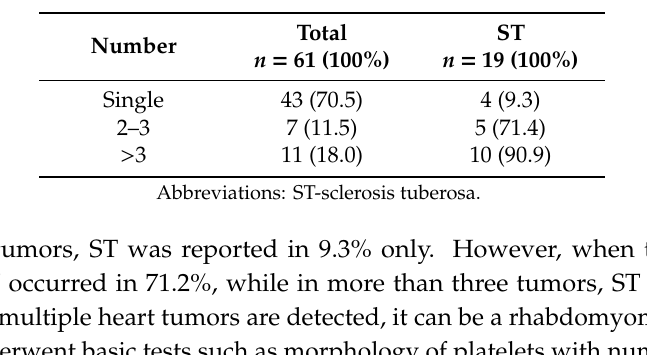
Table 5. Number of tumors in the heart and sclerosis tuberosa.